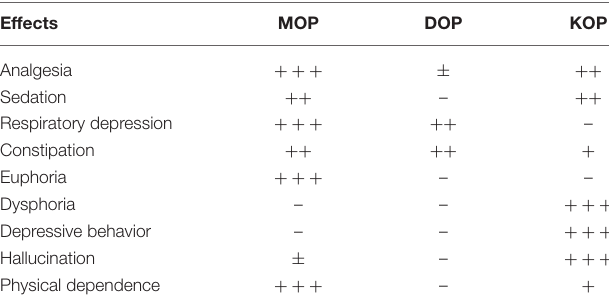
TABLE 1 | Varying degree of opioid receptor involvement in some pharmacological effect.